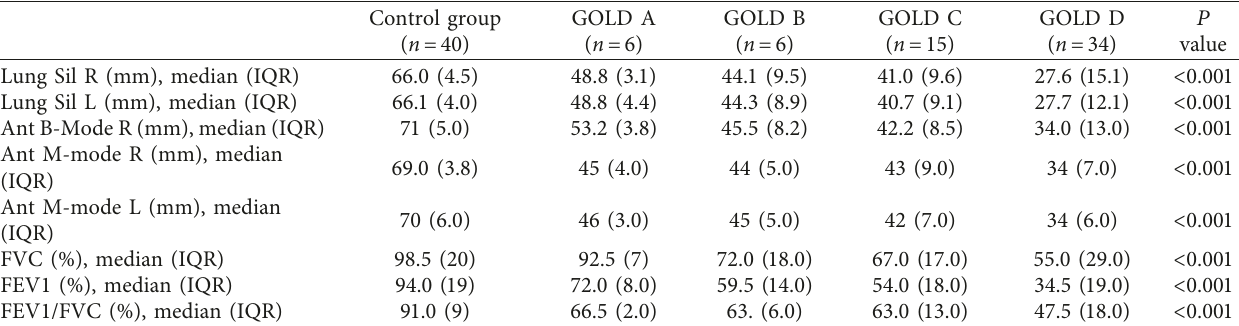
Table 2: Pulmonary function test values and significance levels with ultrasonographic findings according to the COPD stage and control group.